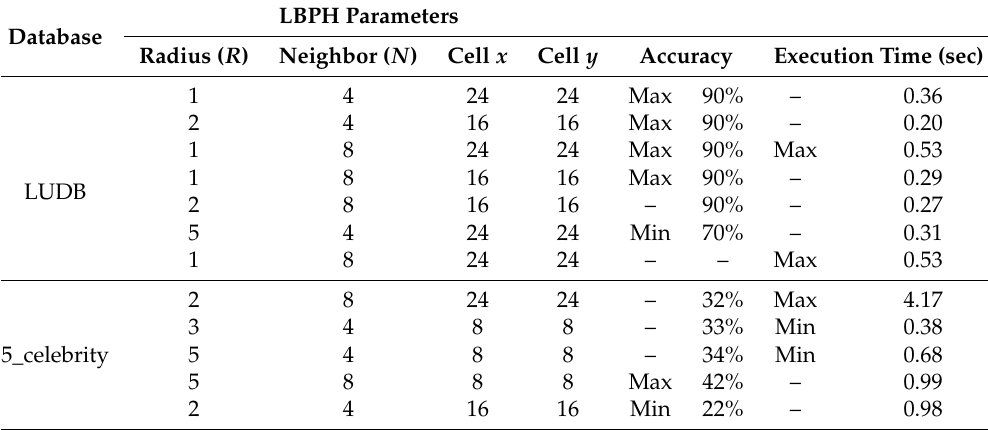
Table 3. Result comparison in Lamar University data base (LUDB) and 5_celebrity